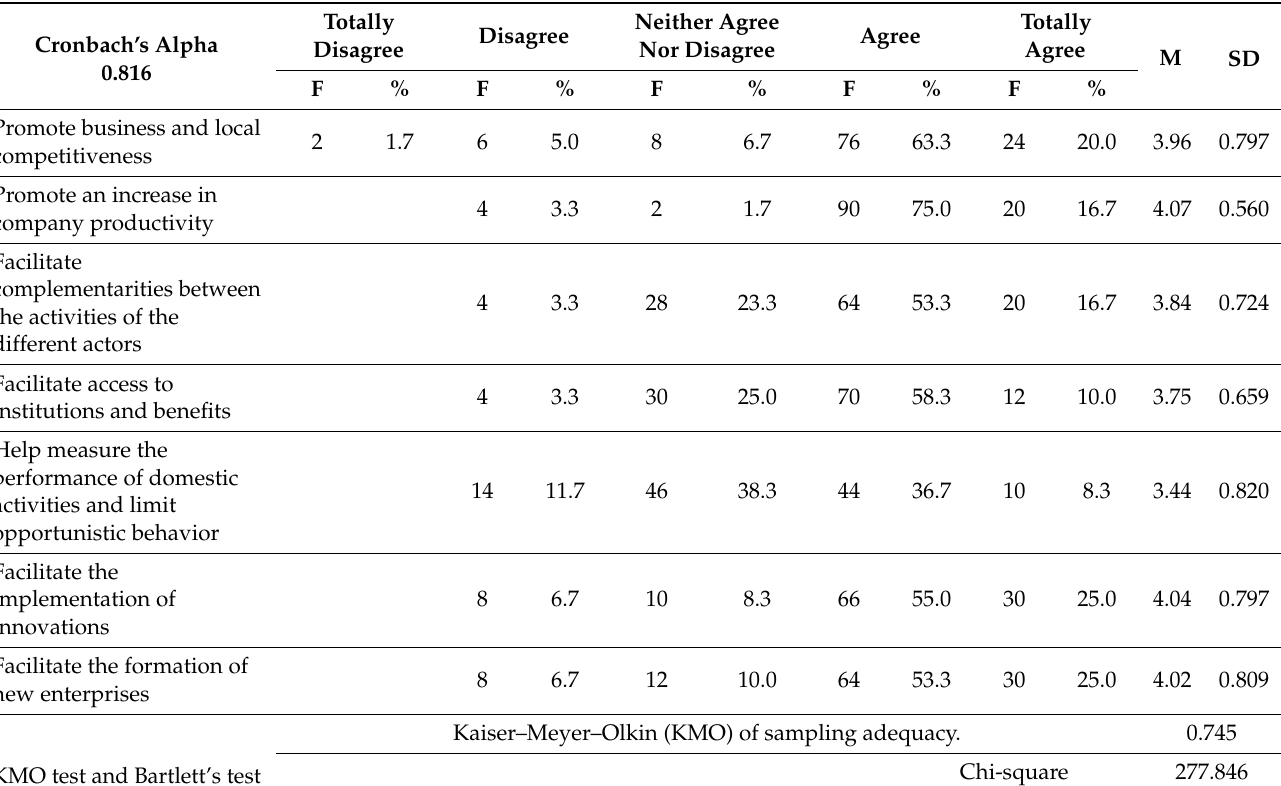
Table 6. Influence of clusters on the development of the economy and business